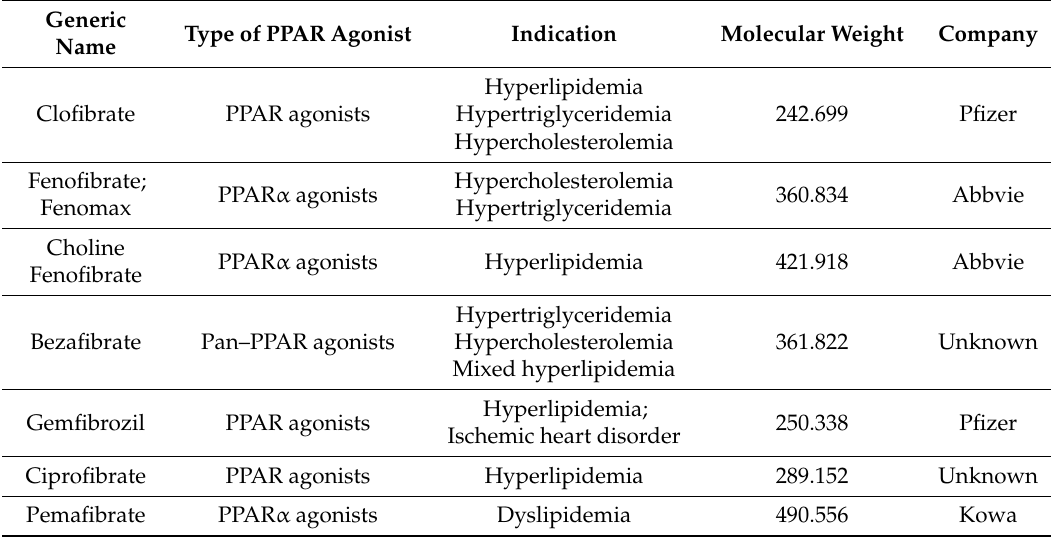
Table 8. Drugs of PPAR ligands for treatment of dyslipidemia in